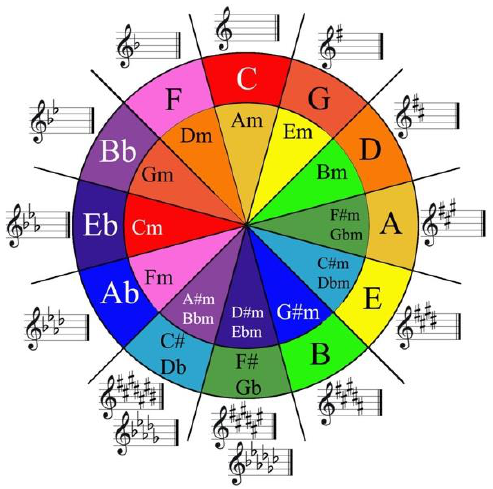
Figure 4. The Circle of Fifths.